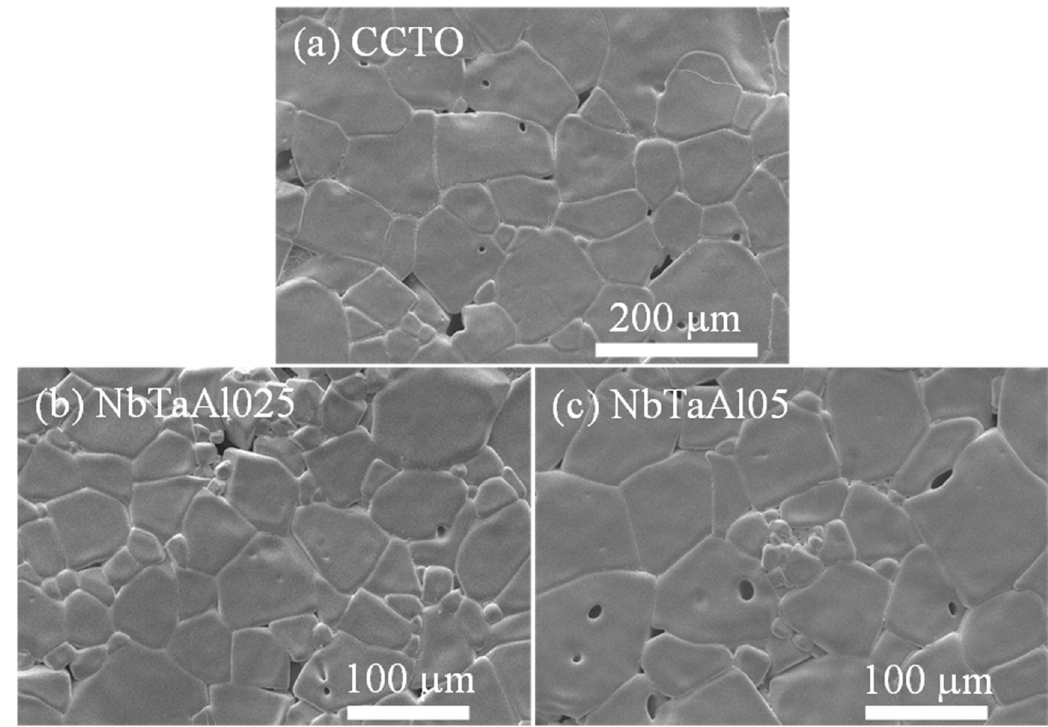
Figure 3. Secondary electron images with magnification of 200 × of surface morphologies of ( a ) CCTO, ( b ) NbTaAl025, and ( c ) NbTaAl05 ceramics using scanning electron microscope with a W filament as an electron source.